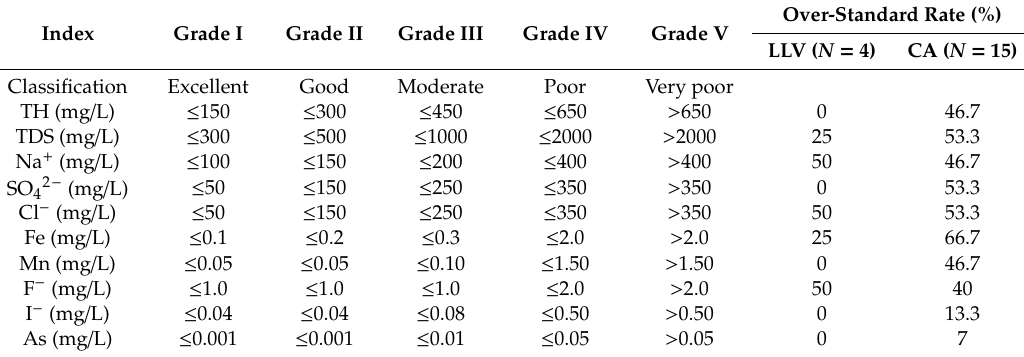
Table 6. Over-standard inorganic components and standard classification.